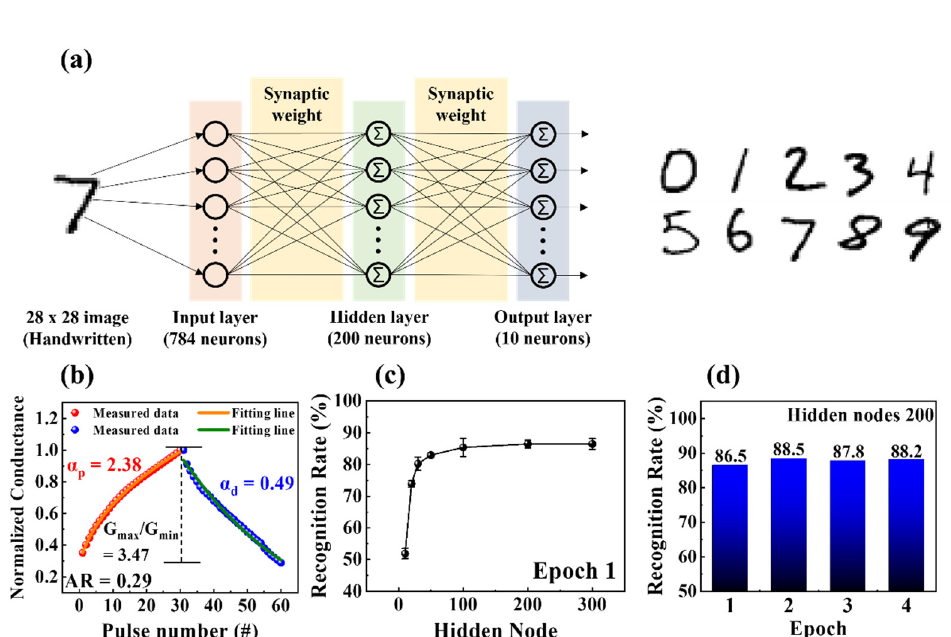
Figure 9. ( a ) Architecture of a three-layer fully connected ANN comprising an input layer, hidden layer, and output layer for handwritten digits recognition. The pixels of the input pattern correspond to each input neuron. ( b ) Nonlinearity analysis for normalized conductance of potentiation and depression (G/G max ). Recognition rates according to ( c ) the number of hidden nodes at epoch 1 and ( d ) the number of epochs with 200 hidden nodes.